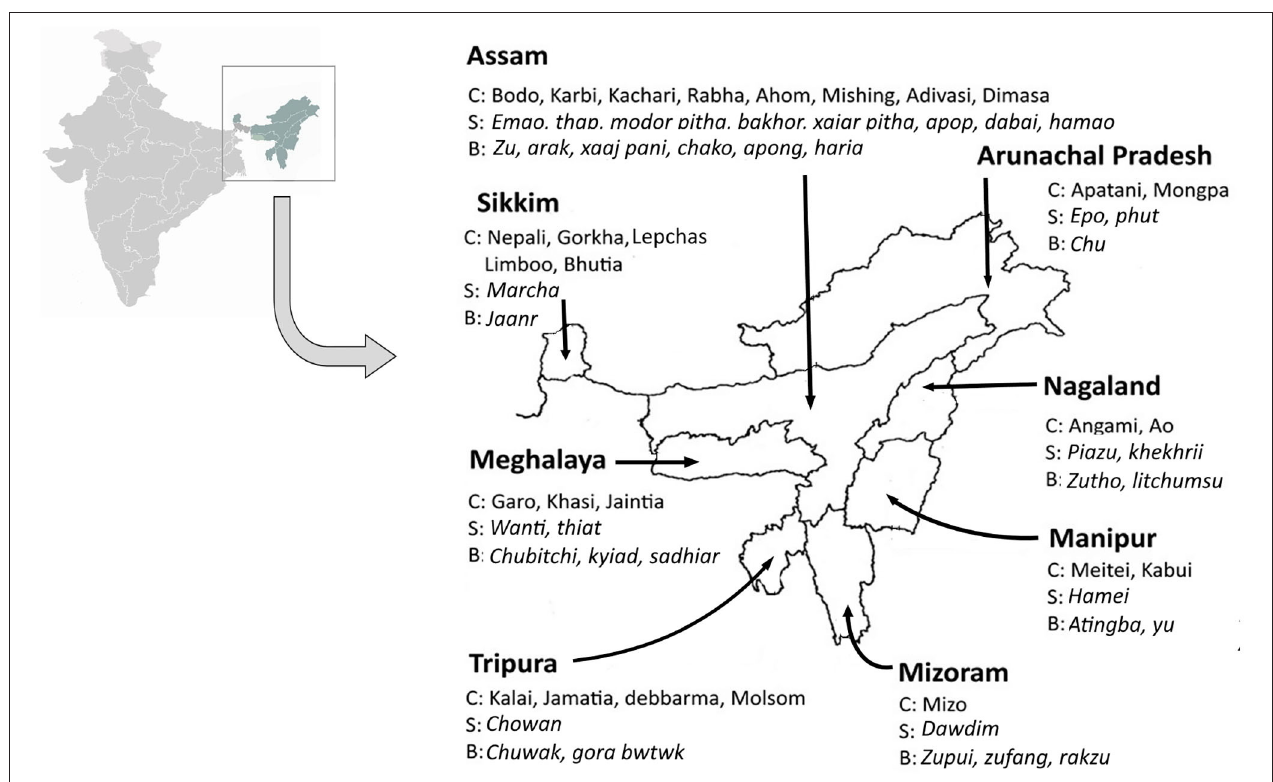
FIGURE 1 | Map of northeast India indicating ethnic communities (C), starter material/cake (S), and fermented beverages (B) associated with ethnic culture of the seven states. This illustration is based on reports by various researchers on yeast population harbored in the starter cakes and their beverages ( Tamang and Sarkar, 1995; Thapa, 2001; Tsuyoshi et al., 2005; Jeyaram et al., 2008; Tanti et al., 2010; Das et al., 2012; Buragohain et al., 2013; Narzary et al., 2016; Parasar et al., 2017; Anupama et al., 2018; Mishra et al., 2018; Sha et al., 2018; Barooah et al., 2020; Majumdar, 2020; Nath et al., 2020a; Thanzami and Lalhlenmawia, 2020; Thapa